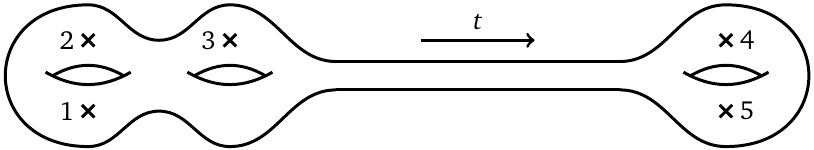
Figure 4: The worldsheet close to a degeneration for a five-point function where a long tube forms. Along the tube, one can consistently define a Lorentzian metric with worldsheet time t along the